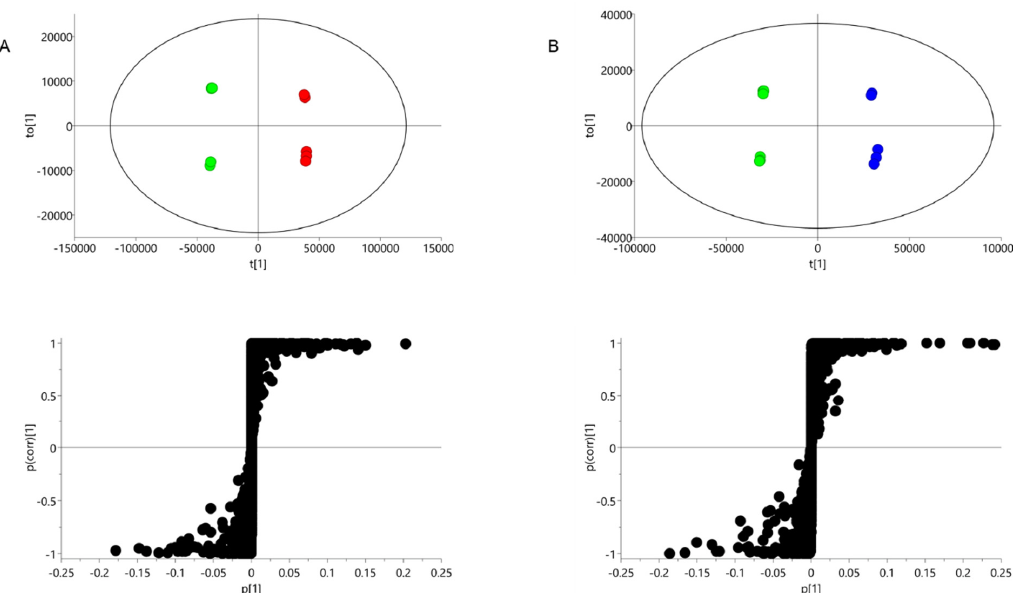
Figure 5. Characterising the effects of nutrient deprivation on lipid metabolism . OPLS-DA scores plots and associated S-plot of positive ion data characterising the disturbances in lipid metabolism in O. tauri induced by ( A ) N-dep and ( B ) P-dep conditions. Key: Complete media = green; N-dep = red; P-dep = blue.